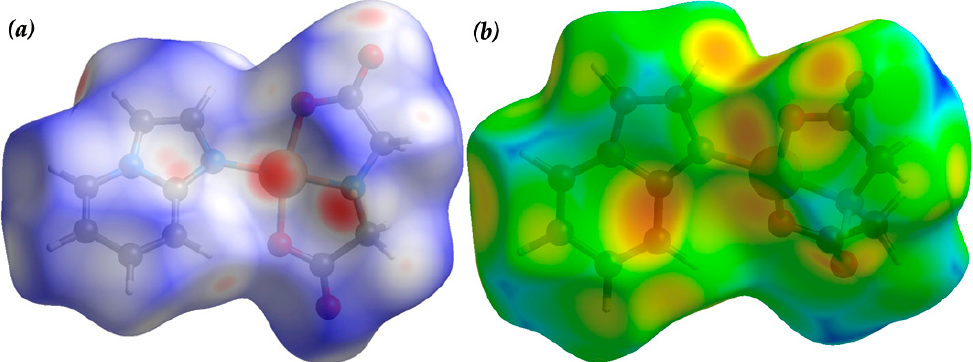
Figure 5. Hirshfeld surface of compound ( 1 ) mapped with d norm ( a ) and d e ( b ).